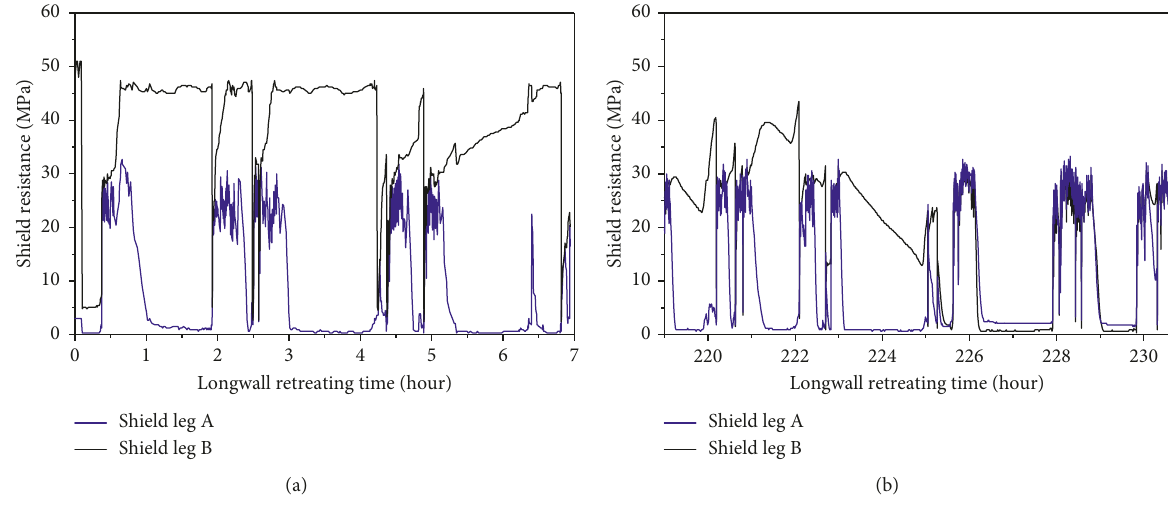
Figure 19: Evolution from rapid leakage in one shield leg (a) to rapid leakage in two shield legs (b).